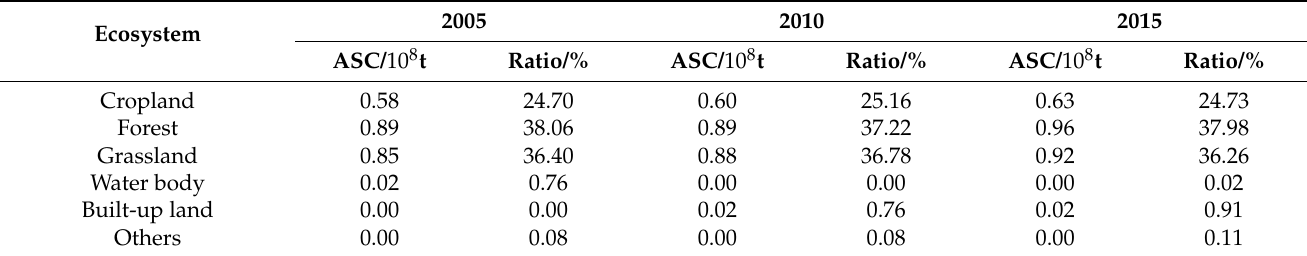
Table 8. Soil conservation services of various ecosystem types.